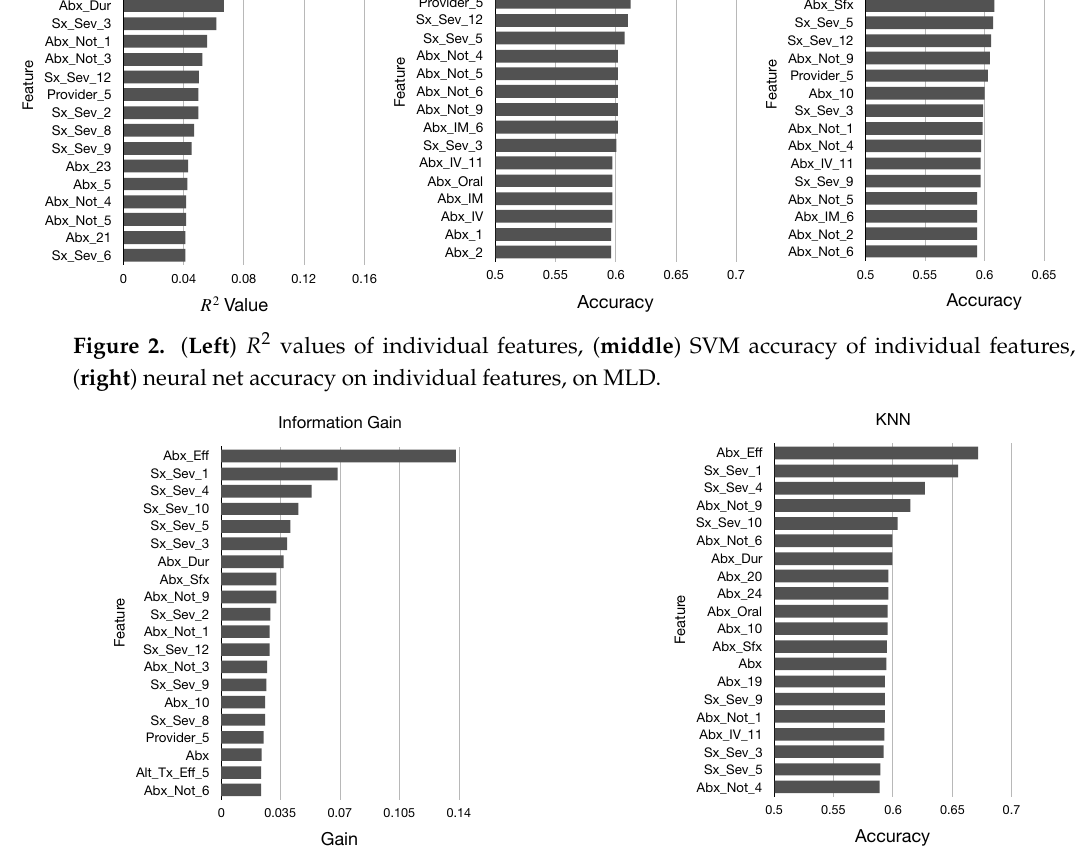
Figure 3. ( Left ) Information gain (decrease in entropy) of individual features, ( right ) KNN accuracy on individual features, on